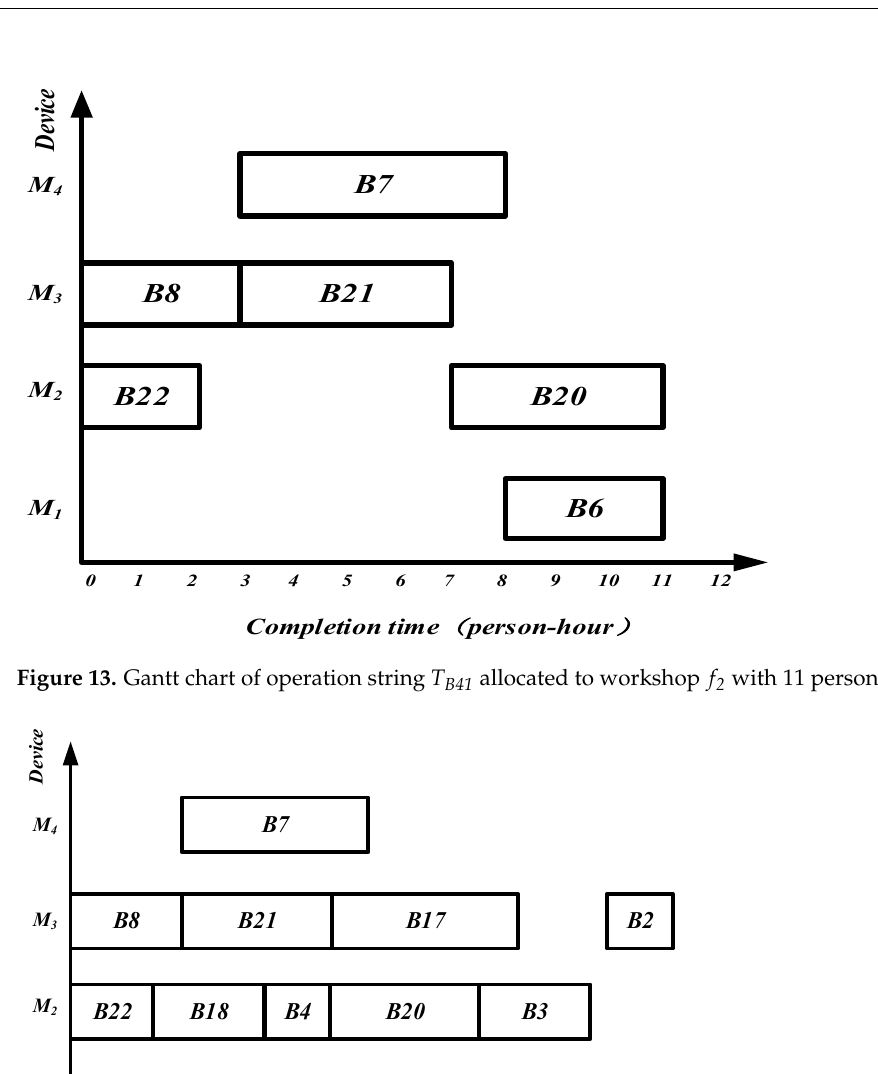
Figure 14. Gantt chart of operation strings, { B5 , B4 }, { B18 , B17 , B16 }, { B3 , B2 }, allocated to workshop f 2 with 16 f with 16 person ‐ hours. 2